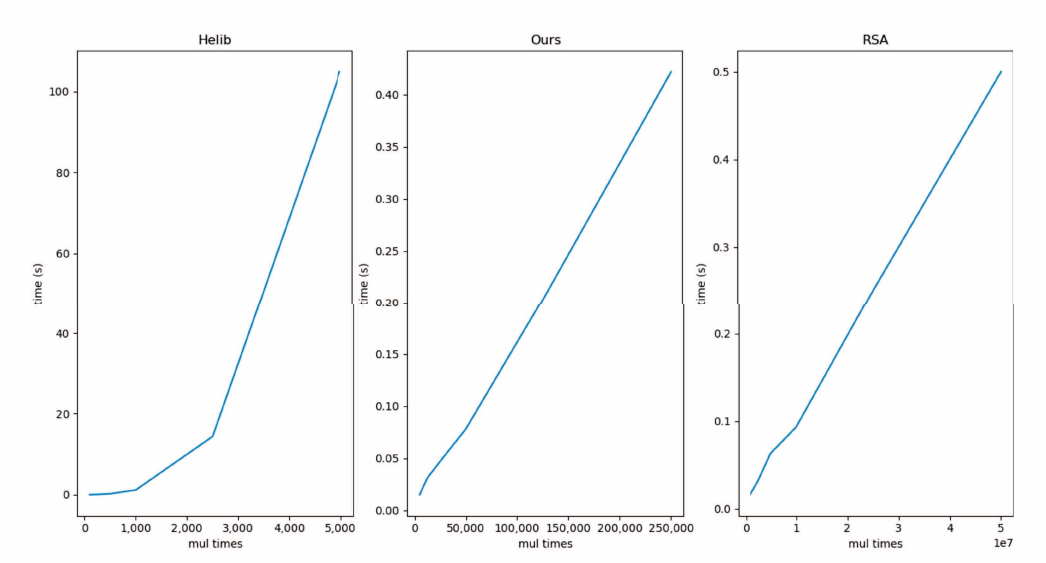
Figure 2. Efficiency